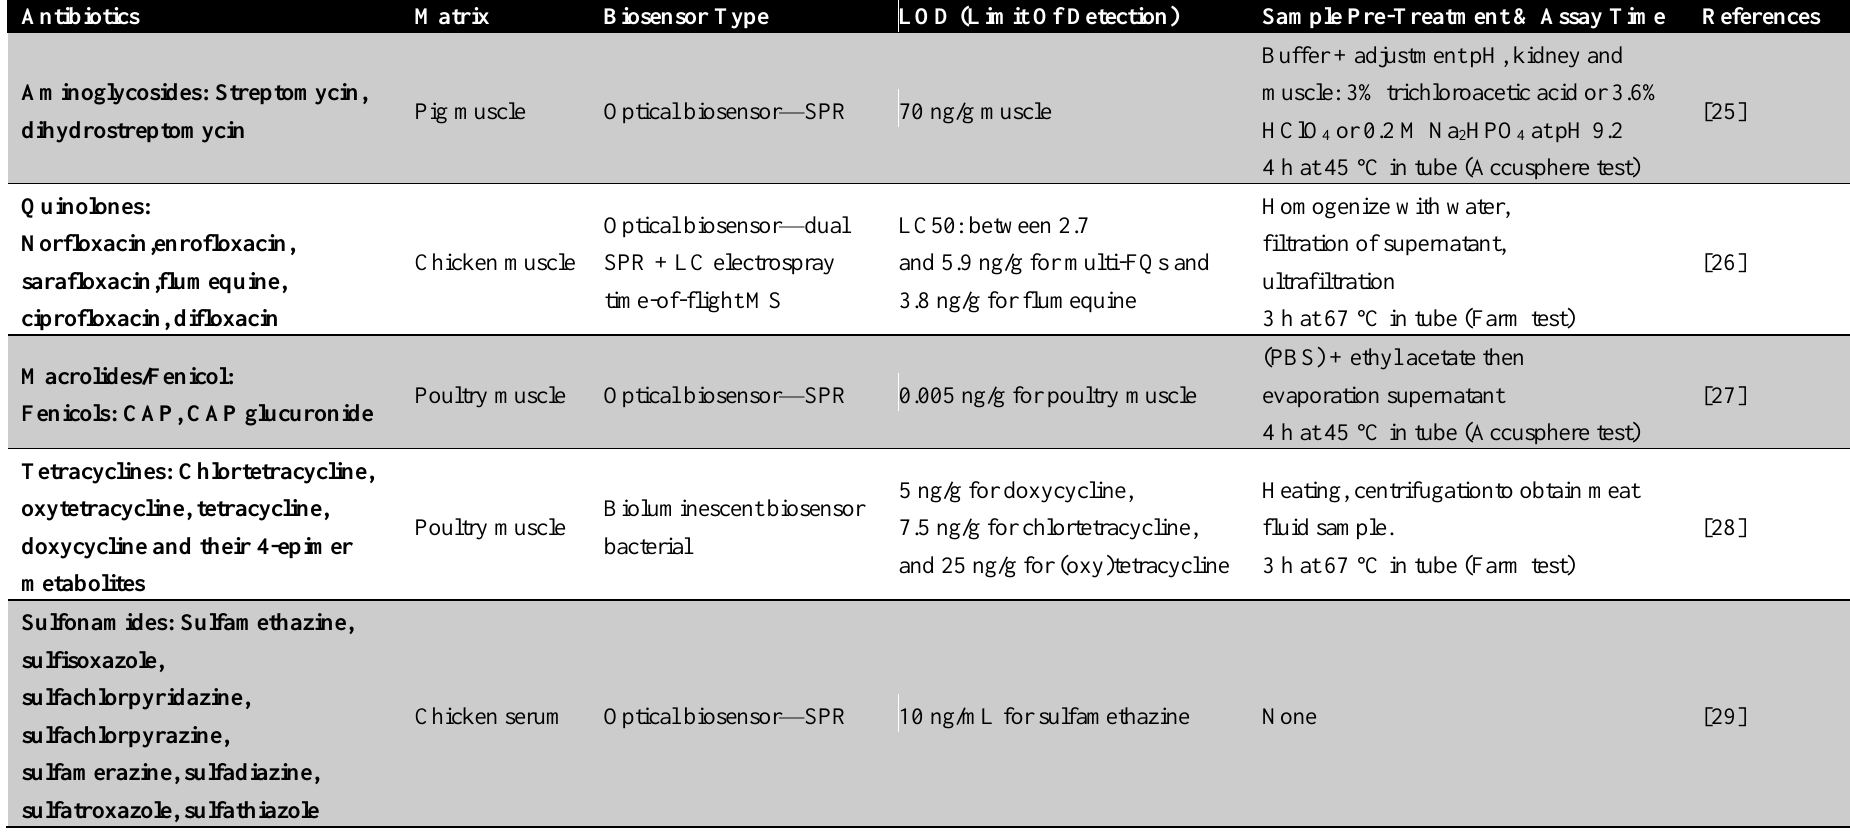
Table 2. Surface plasmon resonance applications in the detection of